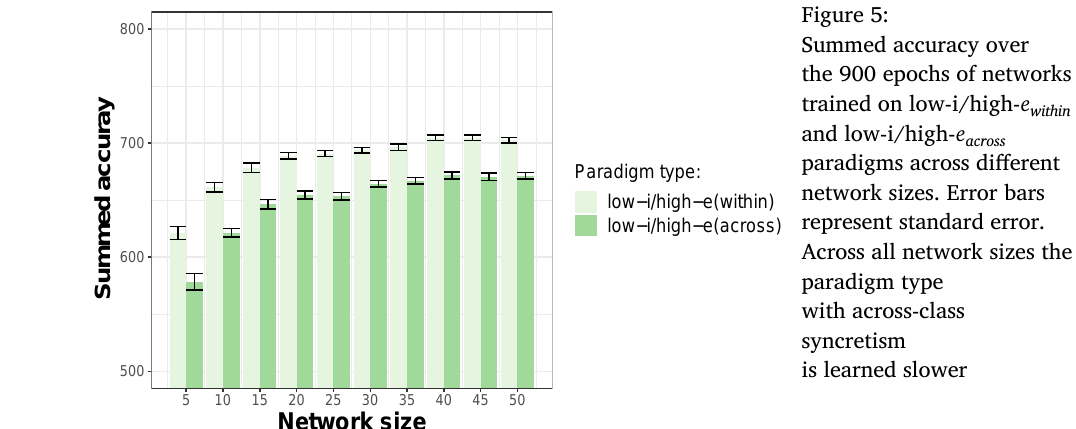
Figure 5: Summed accuracy over the 900 epochs of networks trained on low-i/high- e within and low-i/high- e across paradigms across different network sizes. Error bars represent standard error. Across all network sizes the paradigm type with across-class syncretism is learned